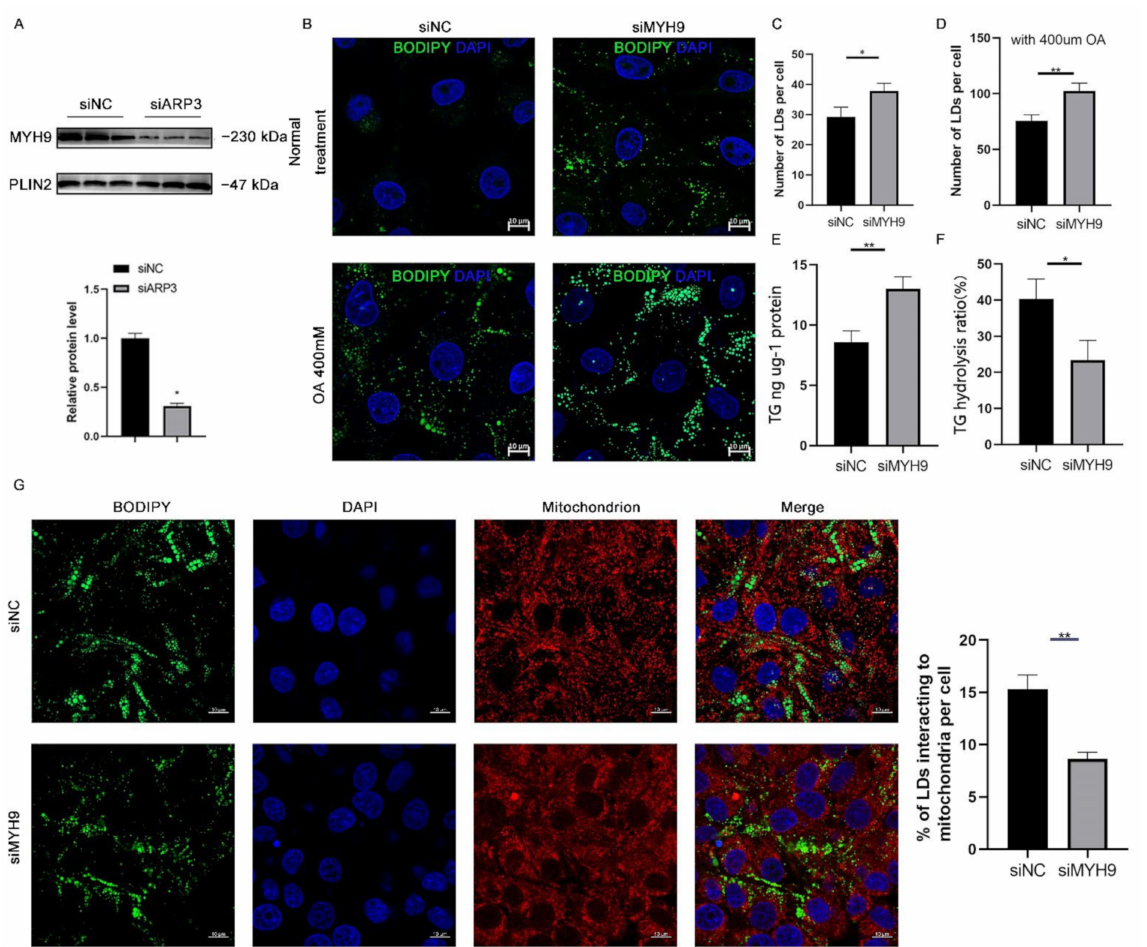
Figure 4. MYH9 regulates LD content. ( A ) The expression of MYH9 of isolated cLDs after interfering with ARP3 and control cells was detected by Western Blot experiments. ( B ) Detection of the cellular LDs marked by BODIPY493/503 through a laser scanning confocal microscope. The Hela cells were transfected with siNC or siMYH9 for 48 h. Subsequently, the cells were treated with 400 µ M oleic acid for another 6 h. Then, the cells were fixed and stained for observation by microscope. bar, 10 µ m. ( C , D ) The gray value analysis of the difference in the number of LDs. * p < 0.05, ** p < 0.01. ( E , F ) Analysis of the difference in the content of triglycerides and hydrolysis rate after interference MYH9. * p < 0.05, ** p < 0.01. ( G ) Detection of the interaction of LDs and mitochondrion after siMYH9. ** p <